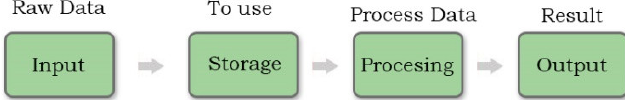
Figure 2. Information Process Cycle.